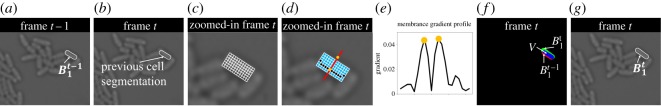
Object tracking process: (a) Segmented bacterial cell B1t−1 in previous frame t−1. (b) Current frame t is superimposed by the segmentation result B1t−1. (c) Split B1t−1 into small windows in current frame t. (d) In current frame t, classify these windows into two categories: with (small windows in black) or without information of cells’ boundaries (small windows in blue) by using intensity gradient profiles along perpendicular direction visualized in a red line. The two points in yellow indicate the edge of cell. (e) An intensity gradient profile. (f) The blue region is the intersection V of B1t−1 and B1t, and the pink region is the intersection of B1t−1 and the background. (g) The intersection V grows to the final boundary of B1 in frame t.